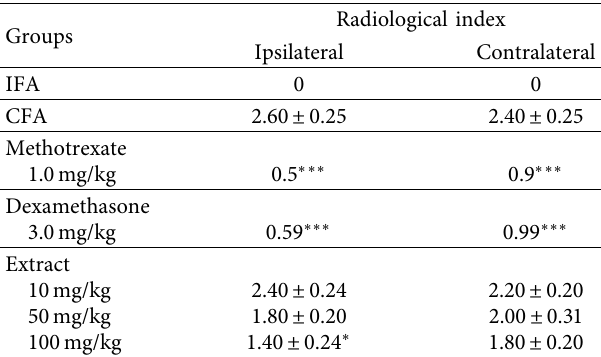
Table 1: Arthritic indices for rats in adjuvant-induced arthritis evaluated from